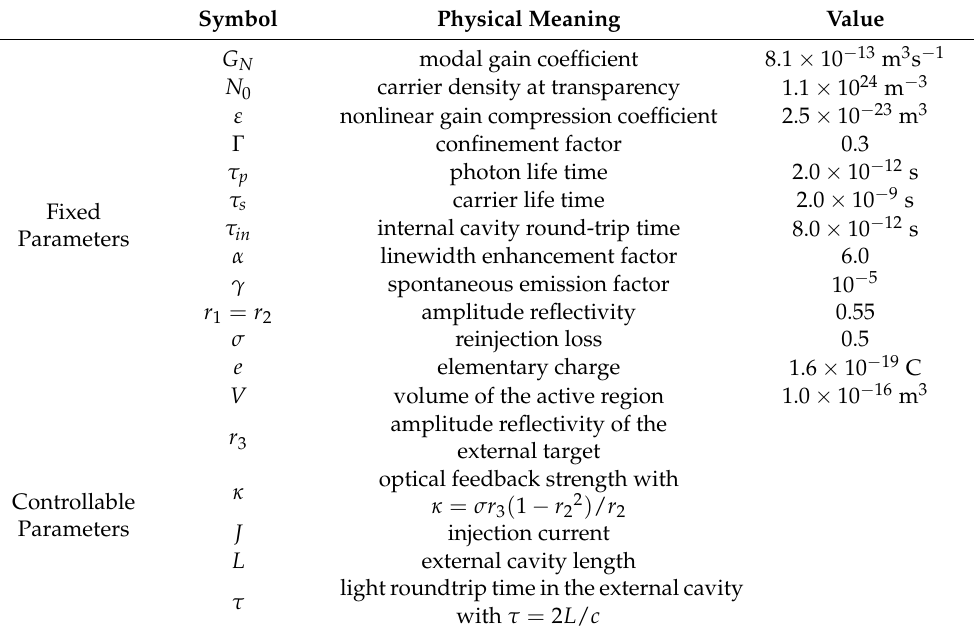
Table 1. Physical meanings and typical values of the symbols in the L–K